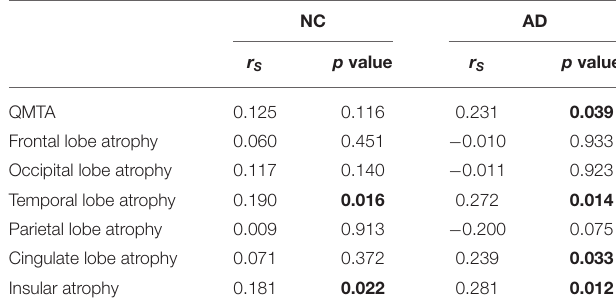
TABLE 5 | Correlation analysis between regional brain atrophy and CHIPS in NC TABLE 3 | Correlation analysis between regional brain atrophy and WMHr. and AD groups. NC AD